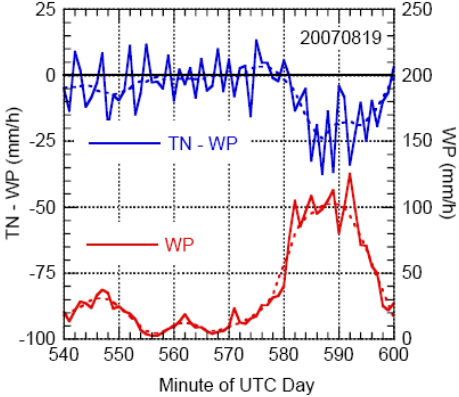
Fig. 6. One-min average wind speeds at 2-m height during first Fig. 6 One-minute average wind speeds at 2-m height during first 60-minute period. 60-min period. 10